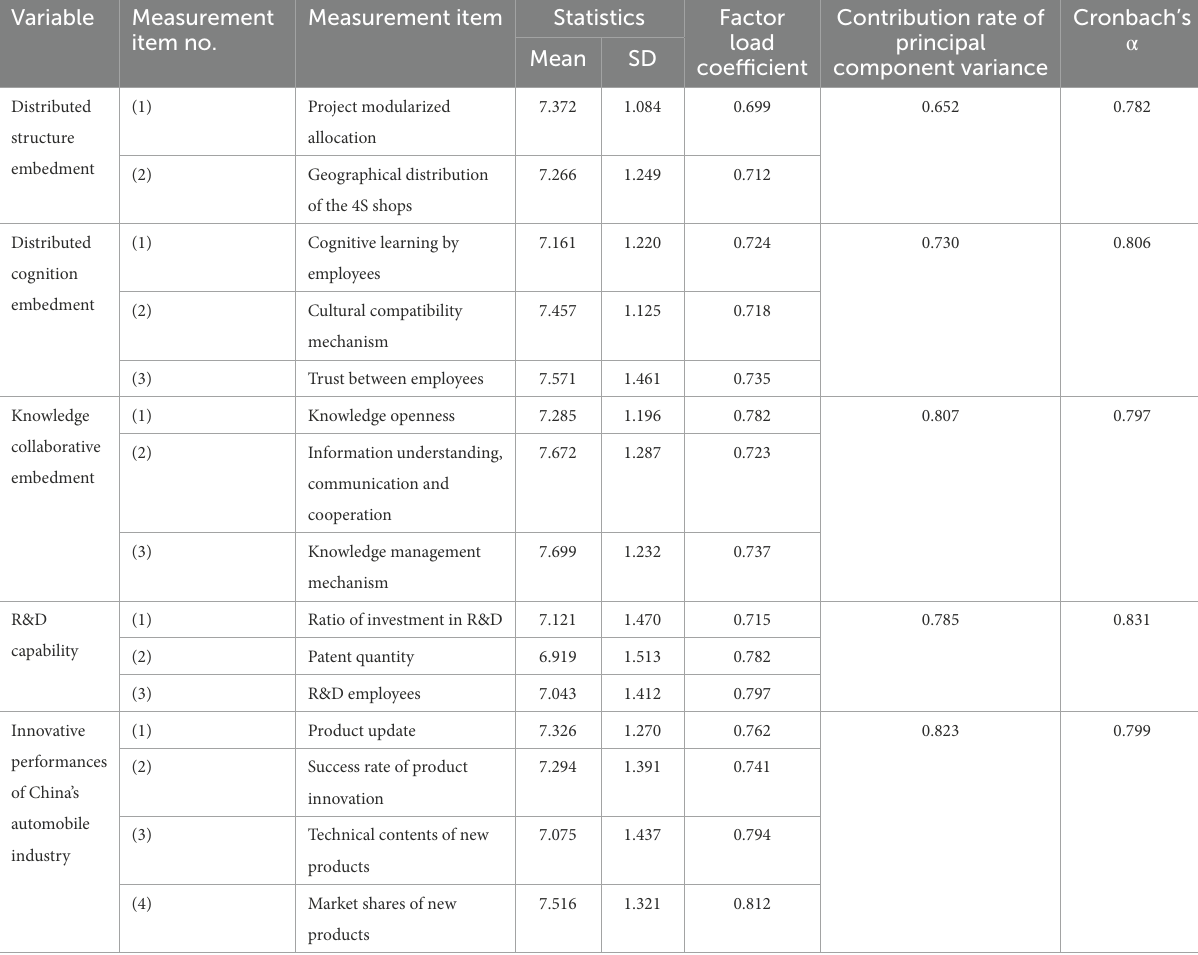
TABLE 1 Results of factors analysis and reliability and validity test.